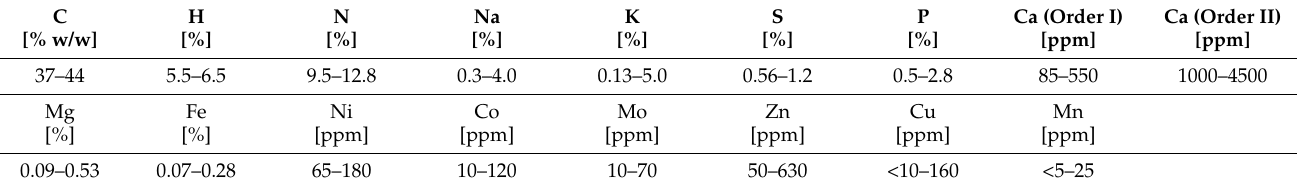
Table 1. Element concentrations in 10 methanogenic species, reported by Scherer, et al.